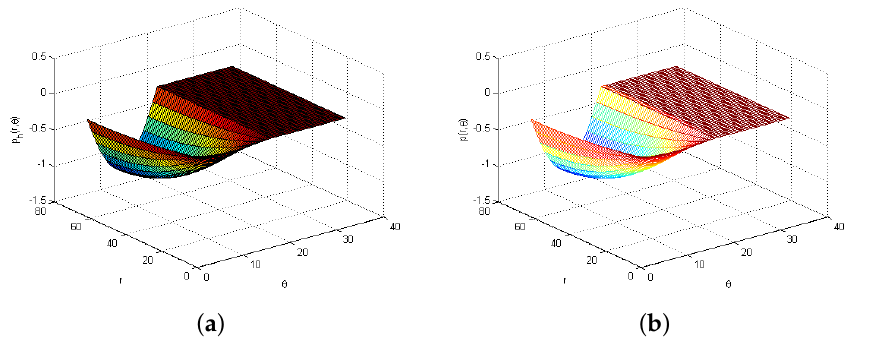
( a ) and exact solution y ( b ) with N = 64. h